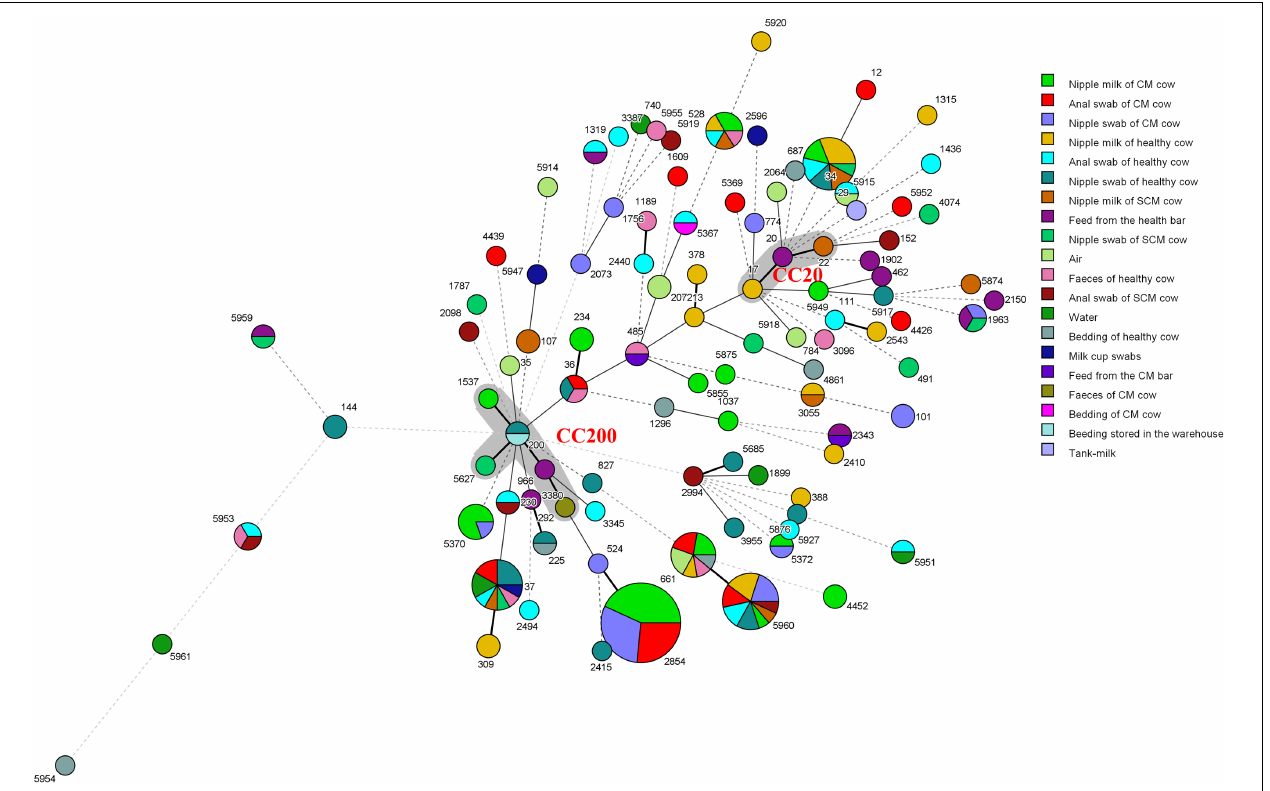
FIGURE 3 | Minimum spanning tree (MST) of 239 K. pneumoniae . The gray area represents a clonal complex and the number represents ST. Each ST is grouped by different sample types. One allele difference is represented by a bold line, two allele differences are represented by a straight line, and three or more allele differences are represented by a dotted